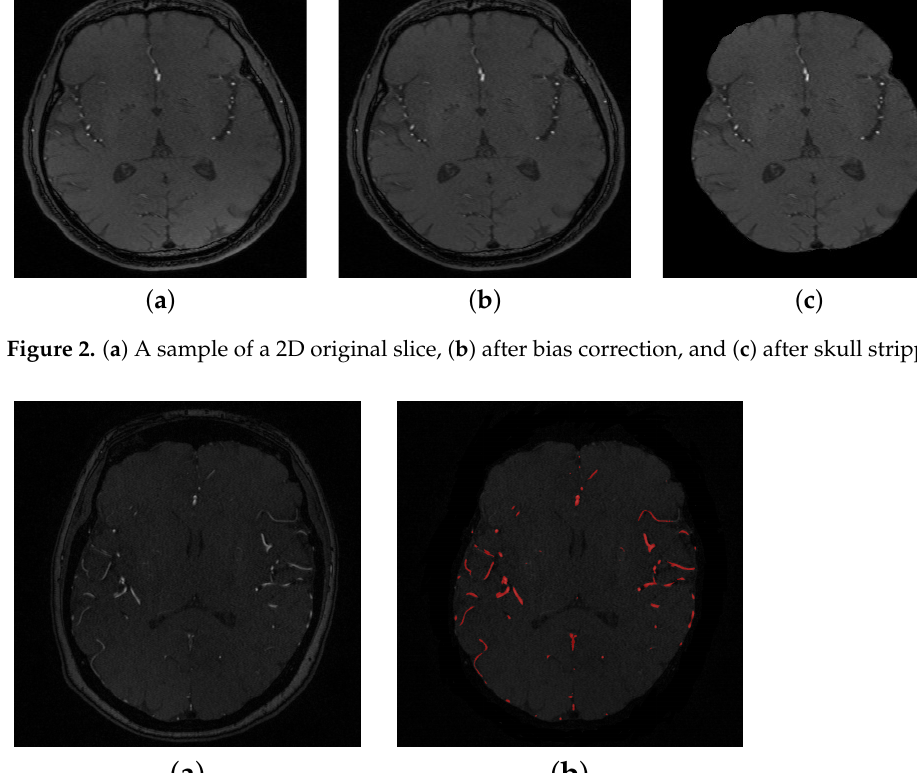
Figure 3. ( a ) A sample of a 2-D original slice, ( b ) Segmented slice where detected blood vessels are colored in Figure 3. (a) A sample of a 2-D original slice, (b) Segmented slice where detected blood vessels are colored in red.